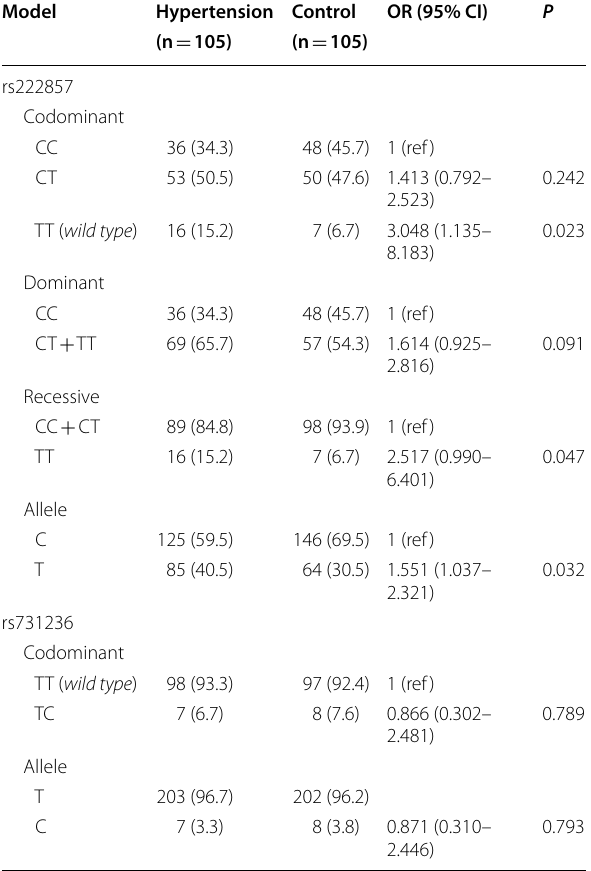
Table 2 Genotype frequency of rs2228570 and rs731236 in